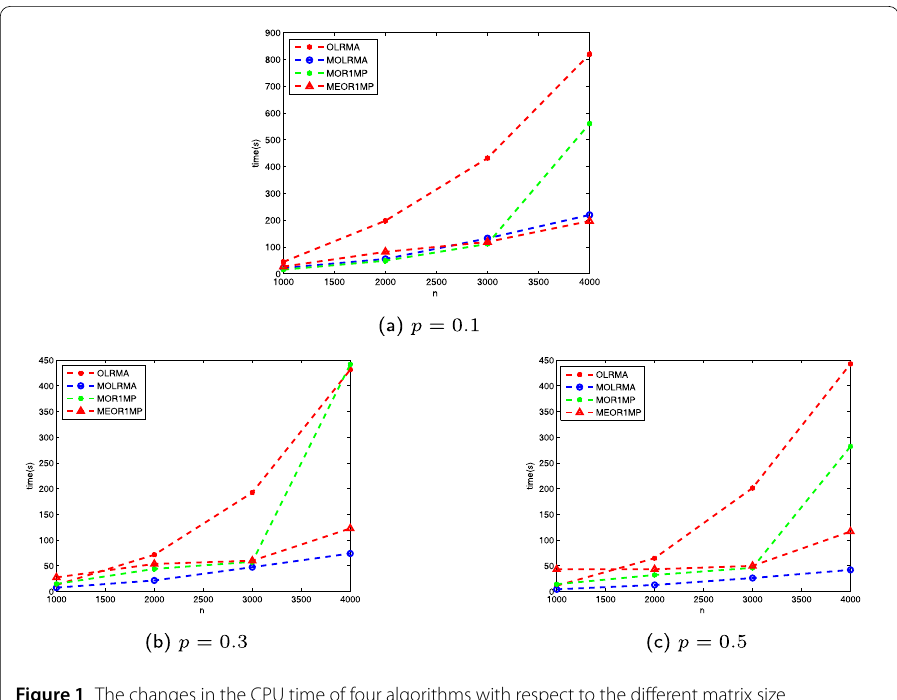
Figure 1 The changes in the CPU time of four algorithms with respect to the different matrix size